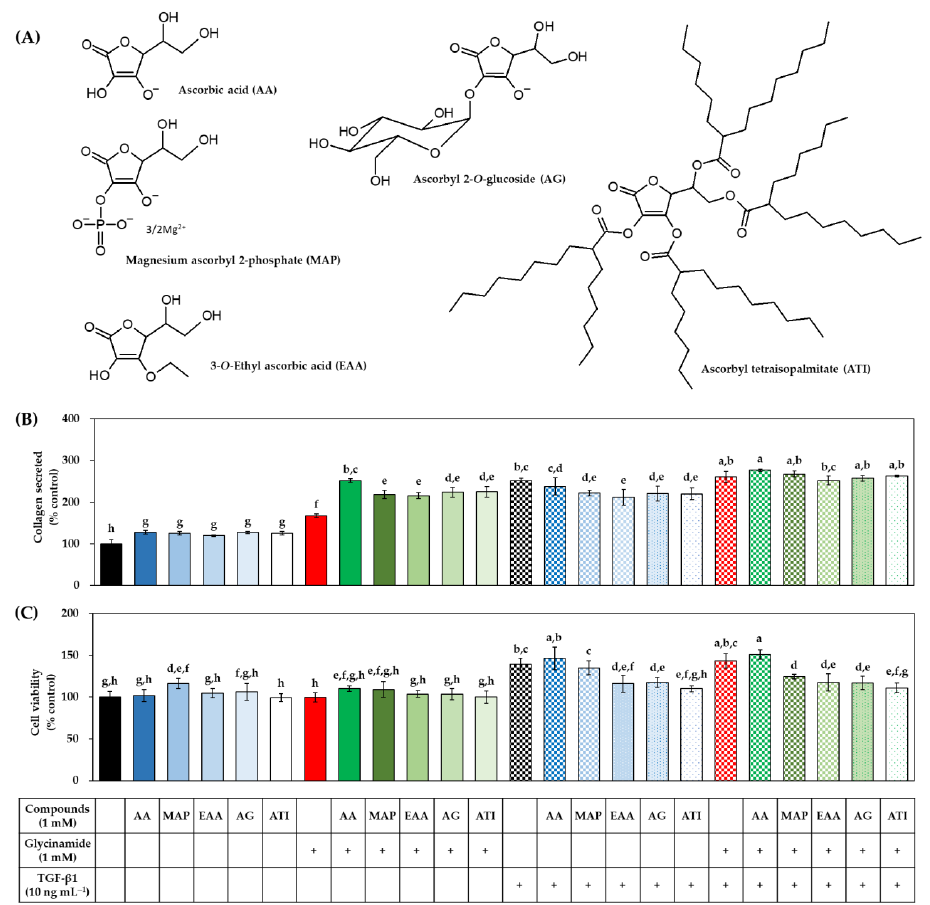
Figure 9. Effects of individual and combined treatments of AA analogs, glycinamide, and TGF- β 1 on the collagen production in HDFs. Chemical structures of AA analogs, such as AA, magnesium ascorbyl 3-phosphate (MAP), 3- O -ethyl ascorbic acid (EAA), ascorbyl 2- O -glucoside (AG), and ascorbyl tetraisopalmitate (ATI), are shown ( A ). Cells were treated with an AA analog alone or in combination with glycinamide and/or TGF- β 1. After 48 h, the collagen protein secreted into the conditioned medium ( B ) and the viability of the adherent cells ( C ) were measured. Data are presented as % of control (means ± SD, n = 3 for ( A ), and n = 5 for ( B )). Groups that share the same alphabet letters (a–h) do not have significantly different means at the p < 0.05